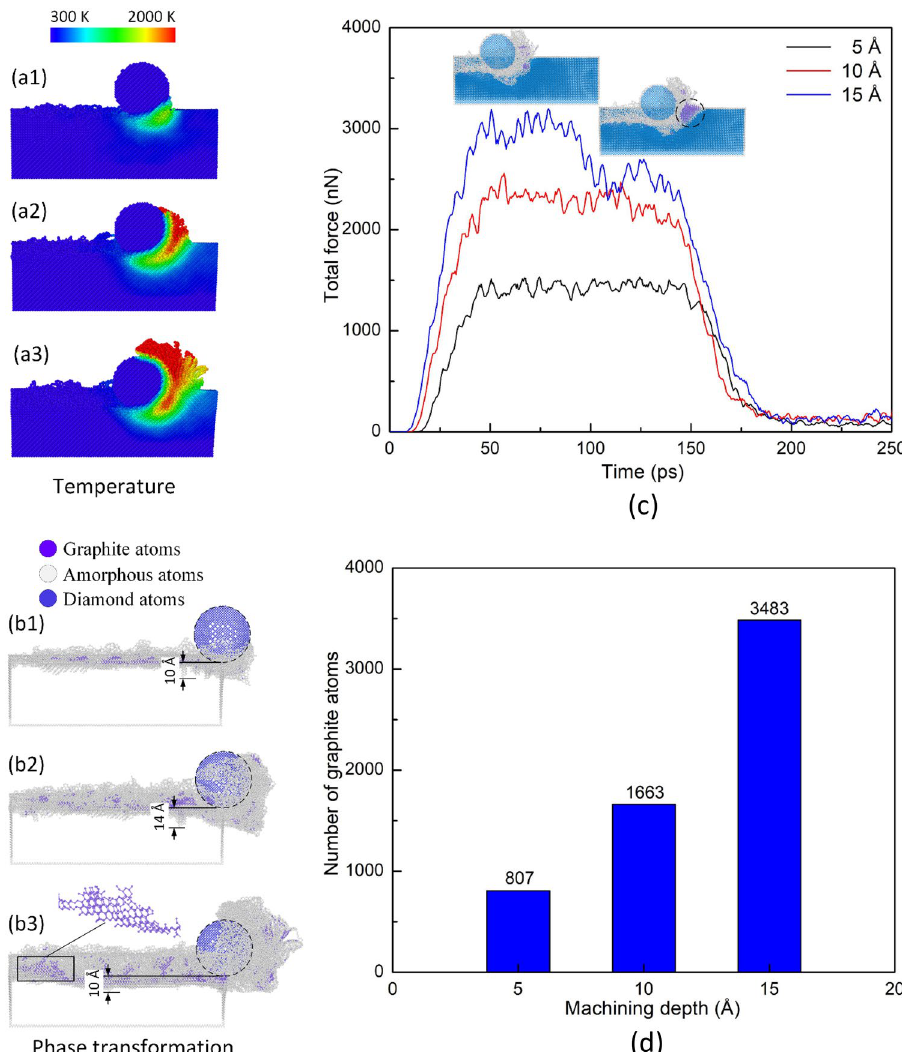
Figure 3. Temperature distribution, phase transformation, force diagram, and number of graphite atoms of different depths at 300 K, 100 m/s: ( a1 , b1 ) 5 Å, ( a2 , b2 ) 10 Å, and ( a3 , b3 ) 15 Å; ( c ) total force; ( d ) number of graphite atoms vs